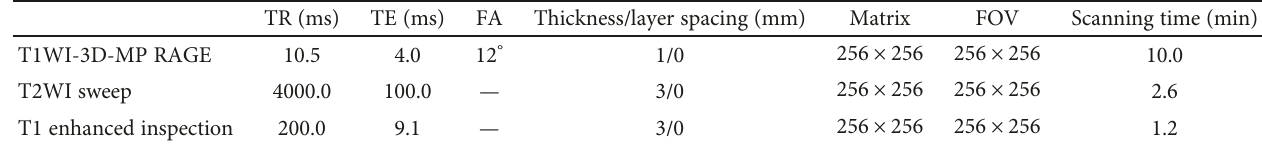
Table 1: Scan parameters of each sequence for MRI